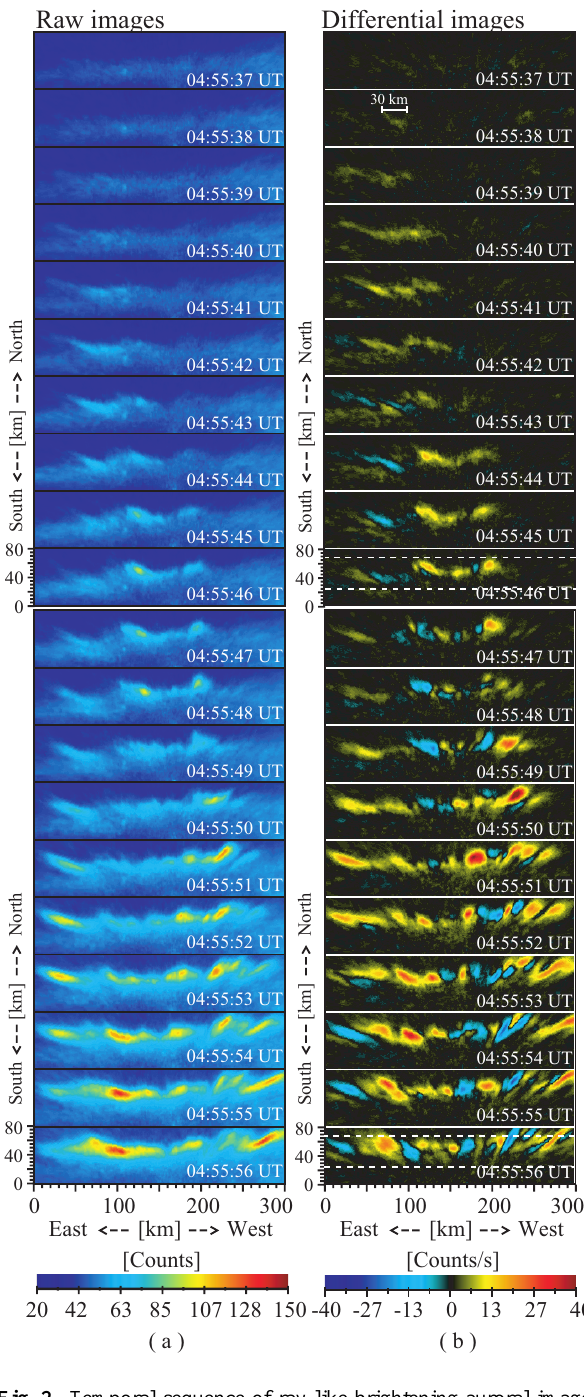
Fig. 2. Temporal sequence of ray-like brightening auroral images every 1s observed at substorm onset at Gillam on 15 January 2008. (a) Left column consists of averaged images over 0.1s in false color. (b) Right column consists of differential images, showing increase (yellow-red) and decrease (blue) of auroral intensity during 1s. A vertical width between two white dashed lines at bottom and middle panels in column (b) indicate the integration range to get Fig. 4a. The magnetic zenith is located beyond bottom of